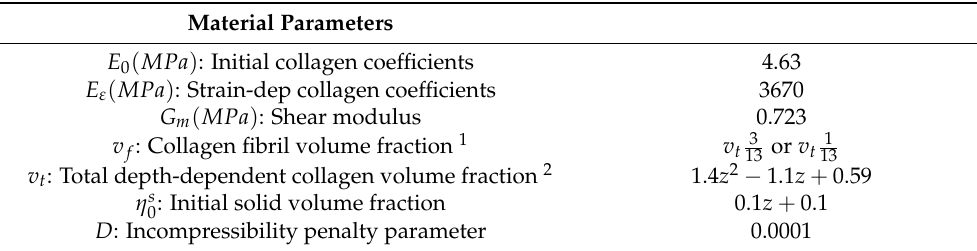
Table 1. Article cartilage materials’ properties.